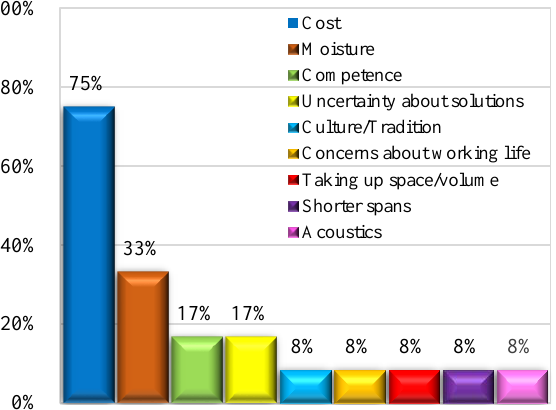
Figure 4. Biggest obstacles against increasing use of wooden frames considered by ERs.